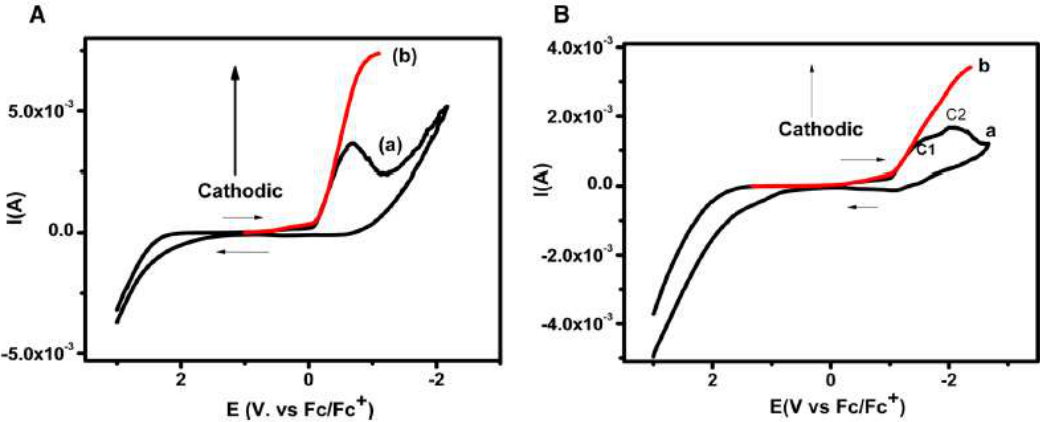
Figure 12. ( A ) Cyclic voltammogram of 5 M thymine at 400 mV / s in [bmim][BF 4 ] depicting; ( a ) original cyclic voltammogram, ( b ) convoluted cyclic voltammogram. ( B ) Cyclic voltammogram recorded at 400 mV s − 1 for 5 mM thymidine in [bmim][BF 4 ], ( a ) original ( b ) convoluted. Reproduced with permission from [60], copyright 2019, Elsevier.